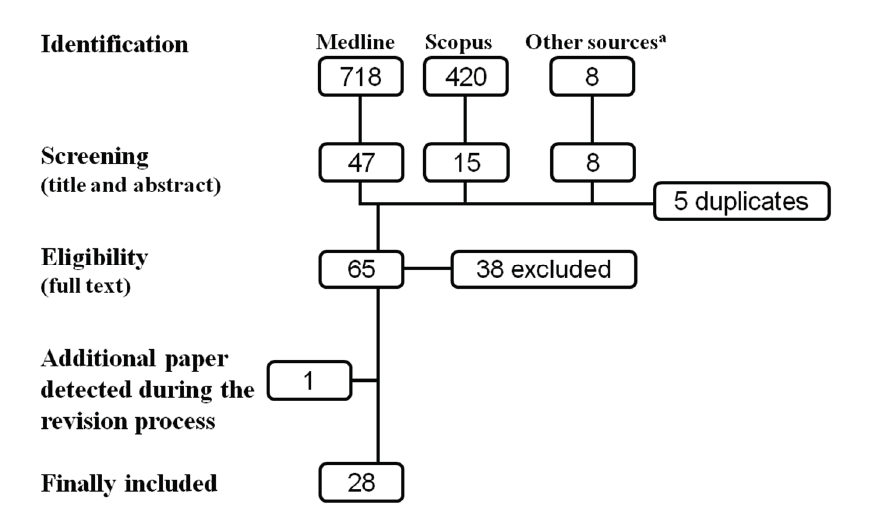
Figure 1. Selection process of the